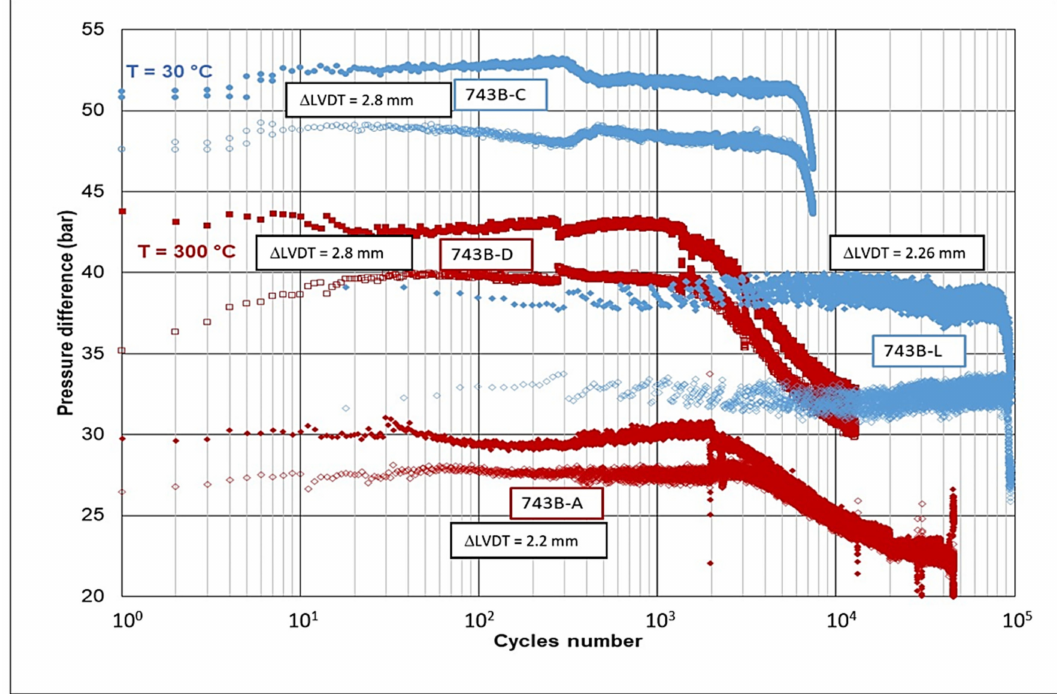
Figure 12. Time evolution of pressure differences in each chamber of the test cell for four tests (tests at a temperature of 30 ◦ C = blue curves, tests at a temperature of 300 ◦ C = red